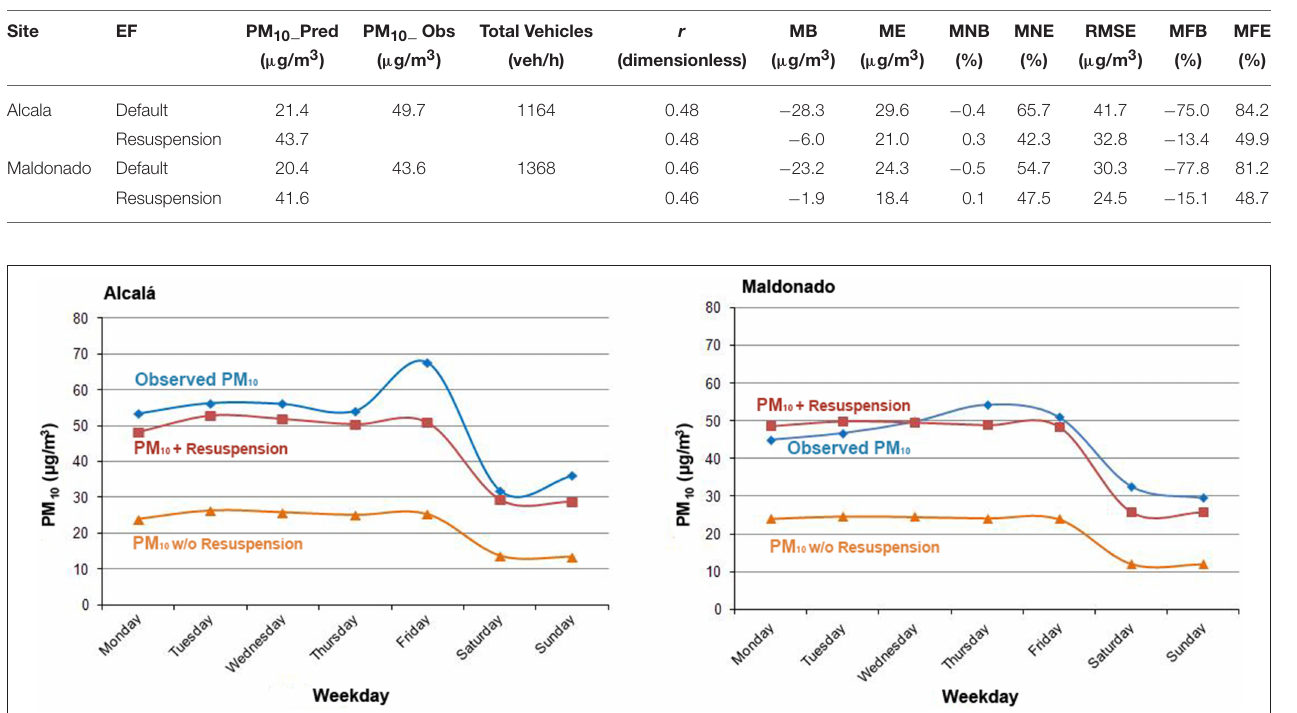
TABLE 4 | Aggregated statistics by Emission Factor for PM 10 concentration in OSPM model for Alcala and Maldonado sites.